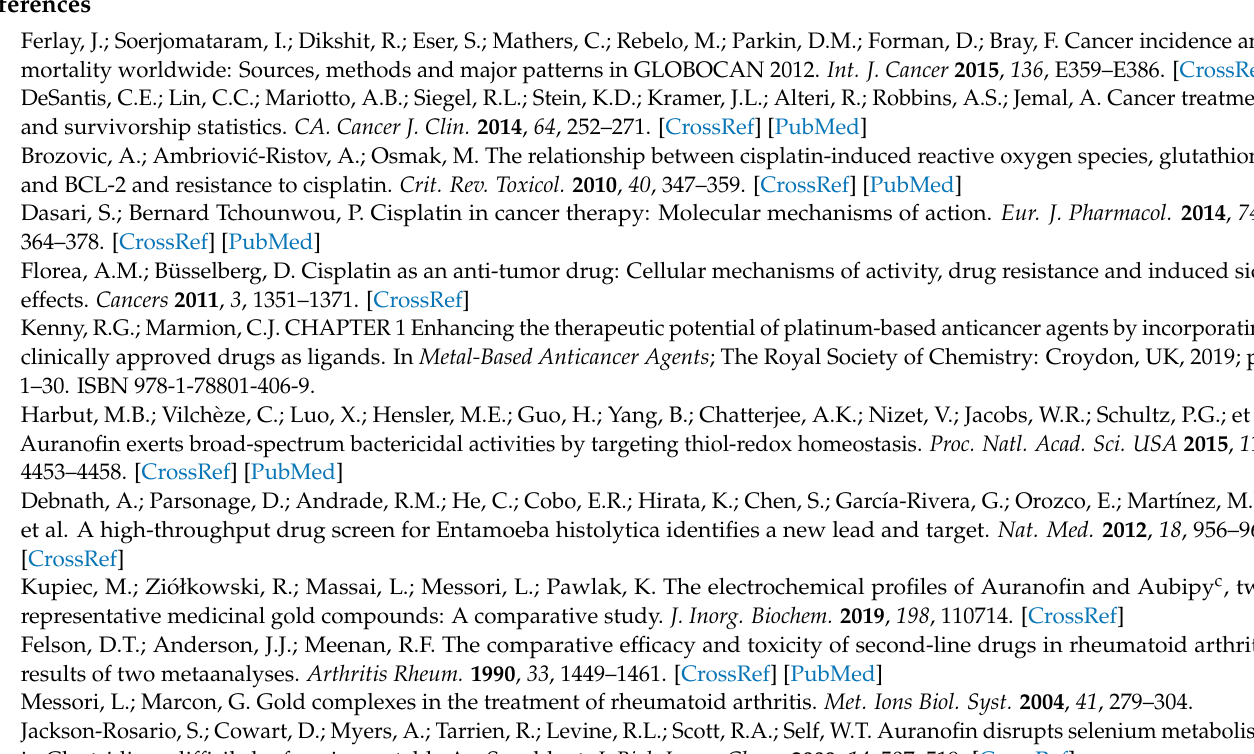
exposed to auranofin. Table S3. Microscope images obtained for cells exposed to cisplatin. Table S4. Statistical characteristics of calibration curves obtained for metal ions obtained by both ICP-MS. Table S5. Number of cells in 100 µ L of cells’ suspension after exposition to metallodrugs. Figure S1. Cytotoxicity of cancer lung cells A549 (A-B) and normal lung cells MRC-5 (C-D) exposed to auranofin and cisplatin established using automatically fitted curves described by Hill equation to relative changes of absorbance obtained via MTT test (Dr Fit software). Figure S2. Number of MRC-5 (A. C) and A-549 (B. D) cells in suspension after exposition to metallodrugs. Figure. S3. Calcium selective staining of lung cancer cells (A549) and normal lung cells (MRC-5) with Rhod-5 AM dye (red) and Fluo-4 AM (green) and changes of Ca2+ amounts in cytosol and mitochondria established as the ratio of the fluorescence obtained for cells exposed to auranofin and cisplatin (FE) against fluorescence obtained for the control group (FC). *— p <